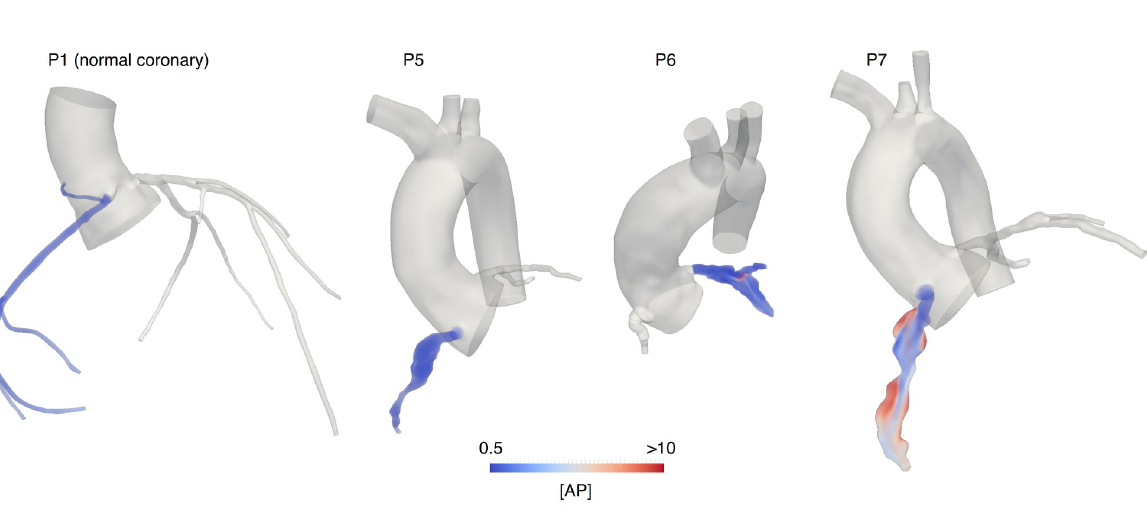
Fig 5. Qualitative comparison of [ AP ] spatial distribution for Kawasakidisease patients classified as low thrombotic risk and a normal coronary artery control. [ AP ] = Activated platelet concentration.